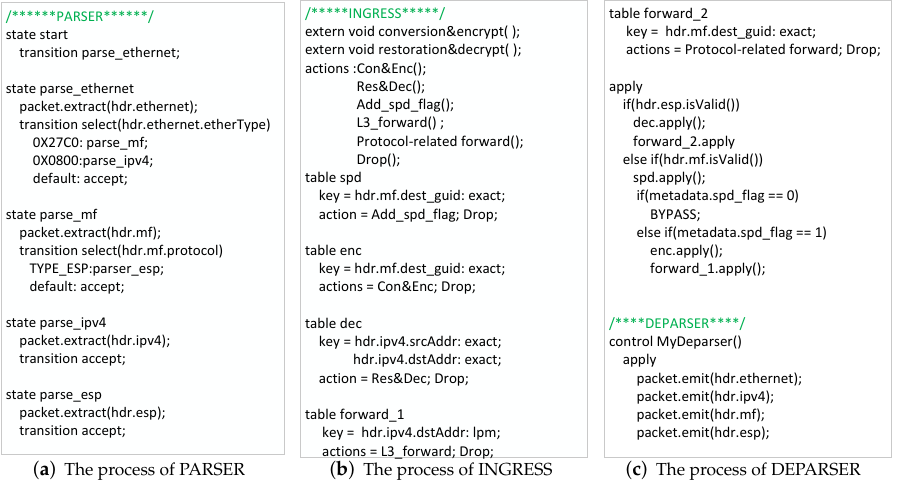
table forward_2 table forward_2 key = hdr.mf.dest_guid: exact; key = hdr.mf.dest_guid: exact; actions = Protocol-related forward; Drop; actions = Protocol-related forward; Drop;